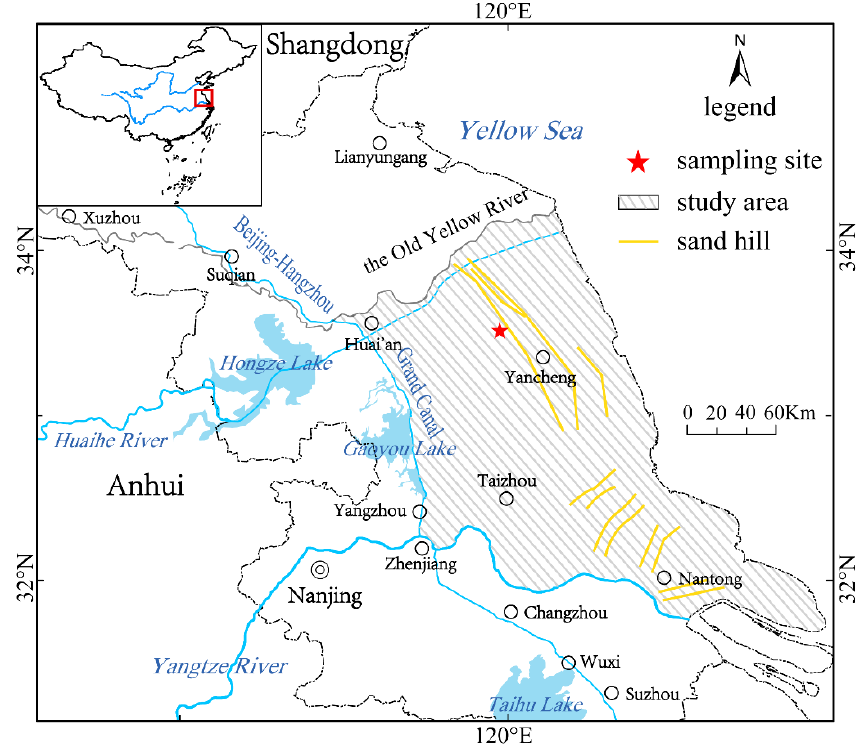
Figure 2. Location of sampling site and sand